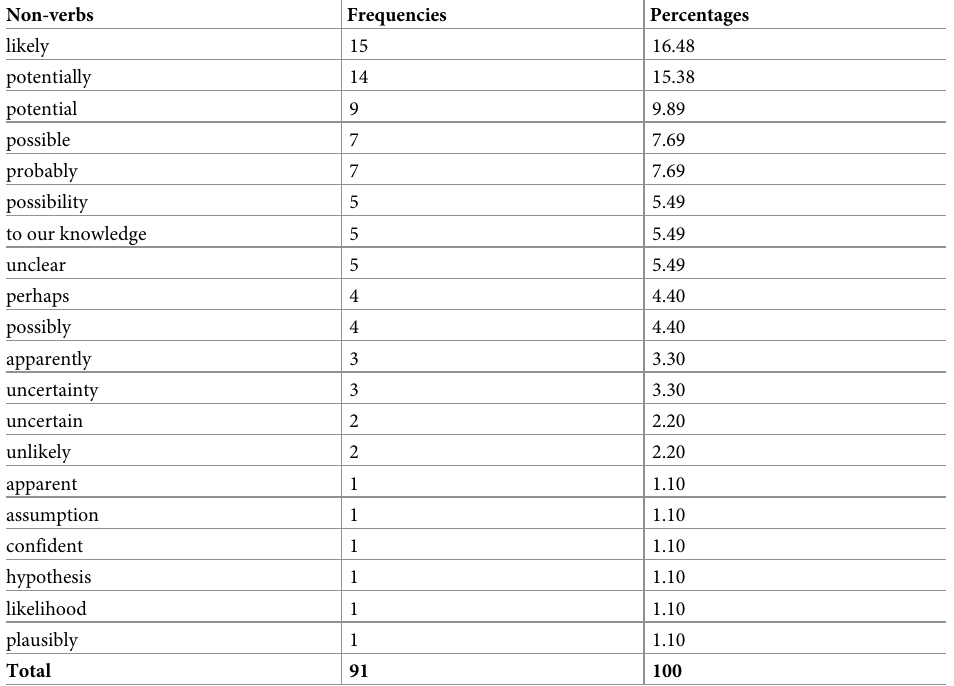
Table 7. Frequencies and percentages of non-verbs.